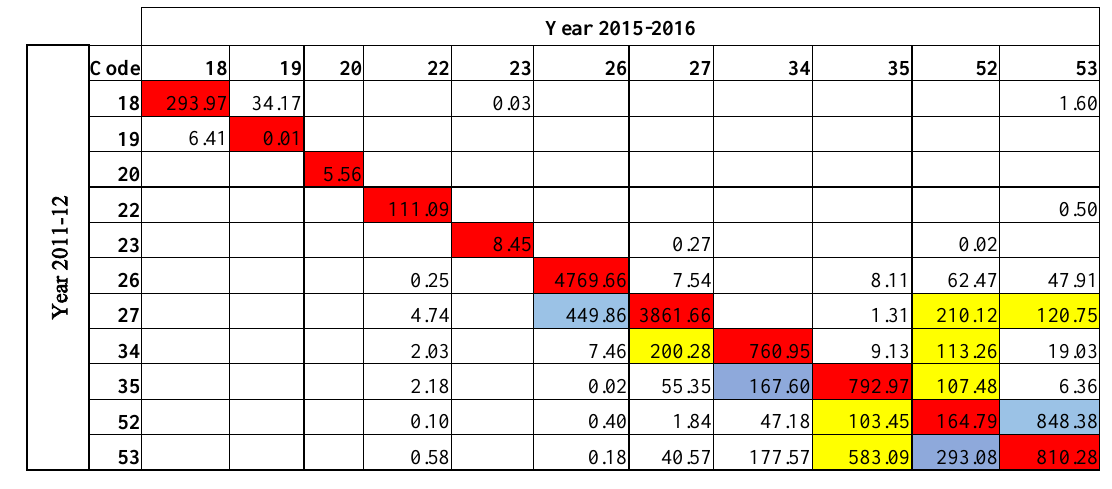
Table 4: Cross matrix change analysis of major land use classes between 2011-12 and 2015-16